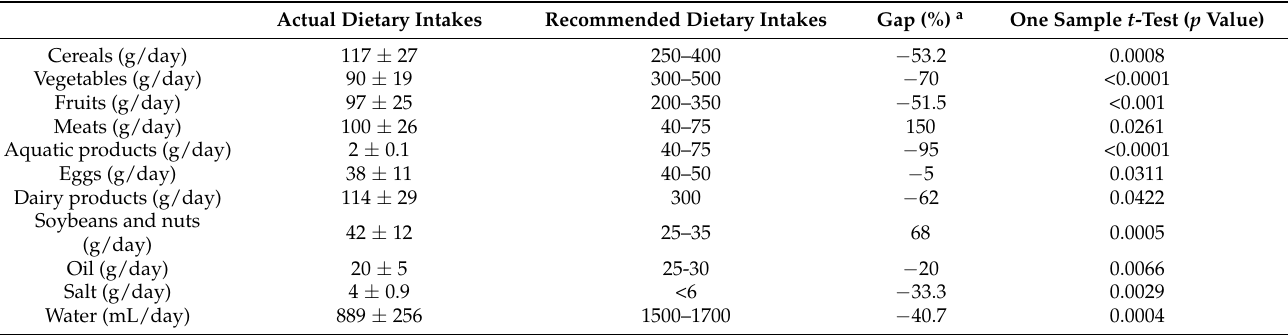
Table 1. Food consumption status of Tibetan local